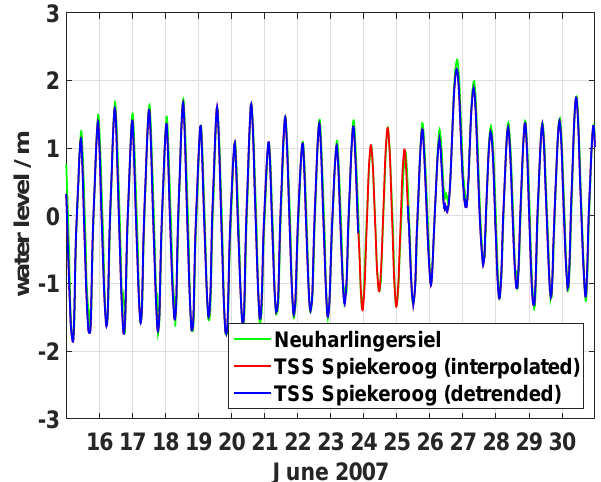
Figure 5. All three curves show data for 2weeks in June 2007. The blue line shows the data after the removal of a trend and outliers and the red curve the interpolated data at the TSS Spiekeroog. The green curve shows data from